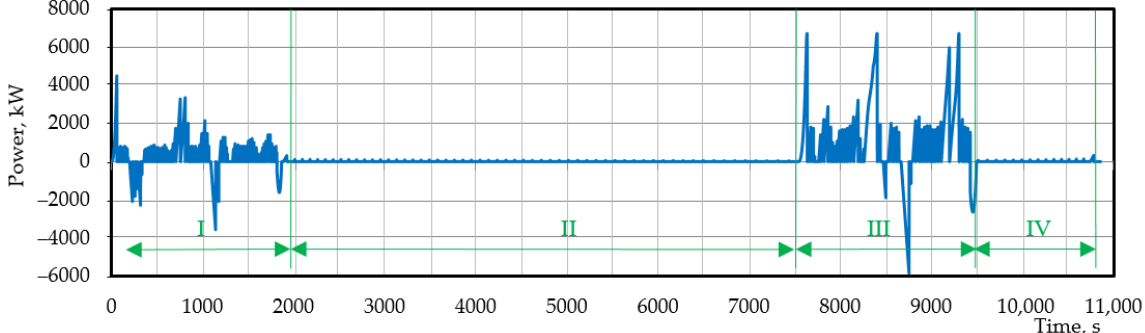
Figure 4. Dependence of the tangential power on the electric locomotive (I—empty half-passage, II—shunting during loading, III—cargo half-passage, IV—shunting during unloading).